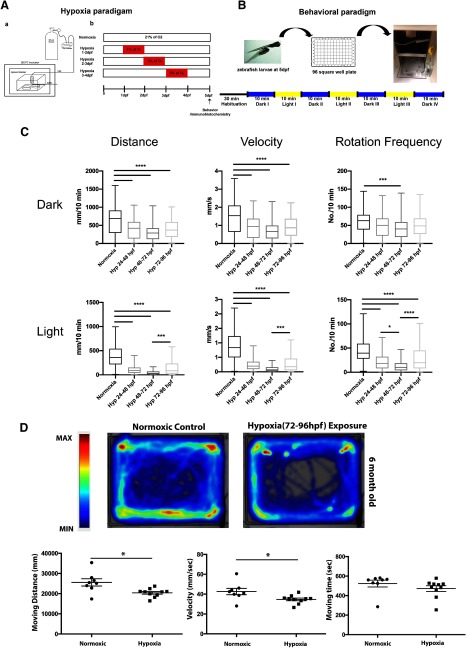
Hypoxia causes impaired motor behavior in larval and adult animals. A, Experimental set-up for hypoxia (a) and time line (b) of hypoxia exposure and analysis. B, Schematic of behavioral testing paradigm. C, Data plots show impaired motor behavior in hypoxia-exposed larvae, each point is a separate animal. Mean shown, ANOVA, ****p < 0.0001, ***p < 0.001. D, top, Heat-map of adult zebrafish (six-month-old) exposed to hypoxia (3- to 4-dpf 5% pO2) shows decreased swimming. Below, Hypoxia-exposed zebrafish have persistent decreases in velocity and distance swum as adults animals (normoxia n = 8, pre-hypoxia n = 10); *p < 0.05; SD shown).